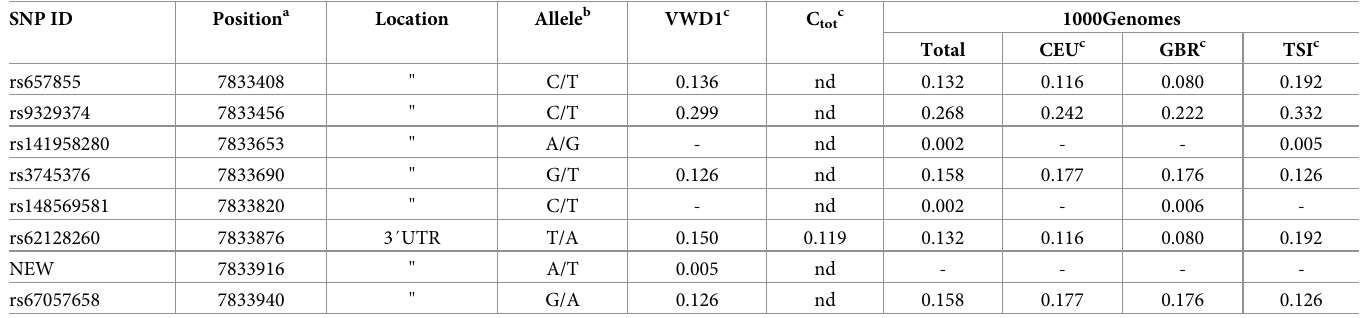
two Swedish control populations (C and C ) and in the type 1 VWD population. The allele 1 2 frequencies of all four SNPs were similar in the C , C and 1000Genomes populations. All four 1 2 SNPs showed allele frequency differences between the type 1 VWD and the control popula- tions. The largest frequency difference and the lowest P -value was observed for rs868875 (5.8%, P = 0.10). The remaining SNPs showed a gradual decrease in their frequency differences with increasing distance from the rs868875 SNP (Table